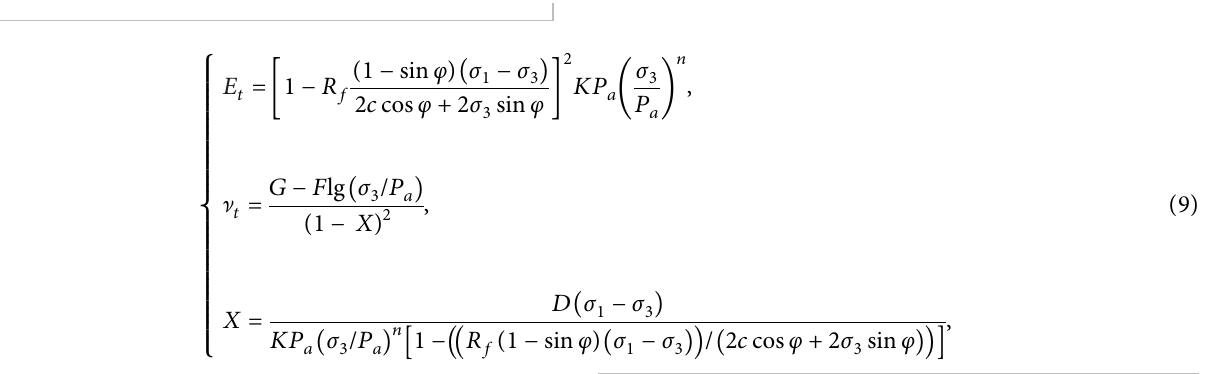
Figure 12: Determination of model parameters. Relation curve of (a) ( σ ε 1 ) − ( − ε 3